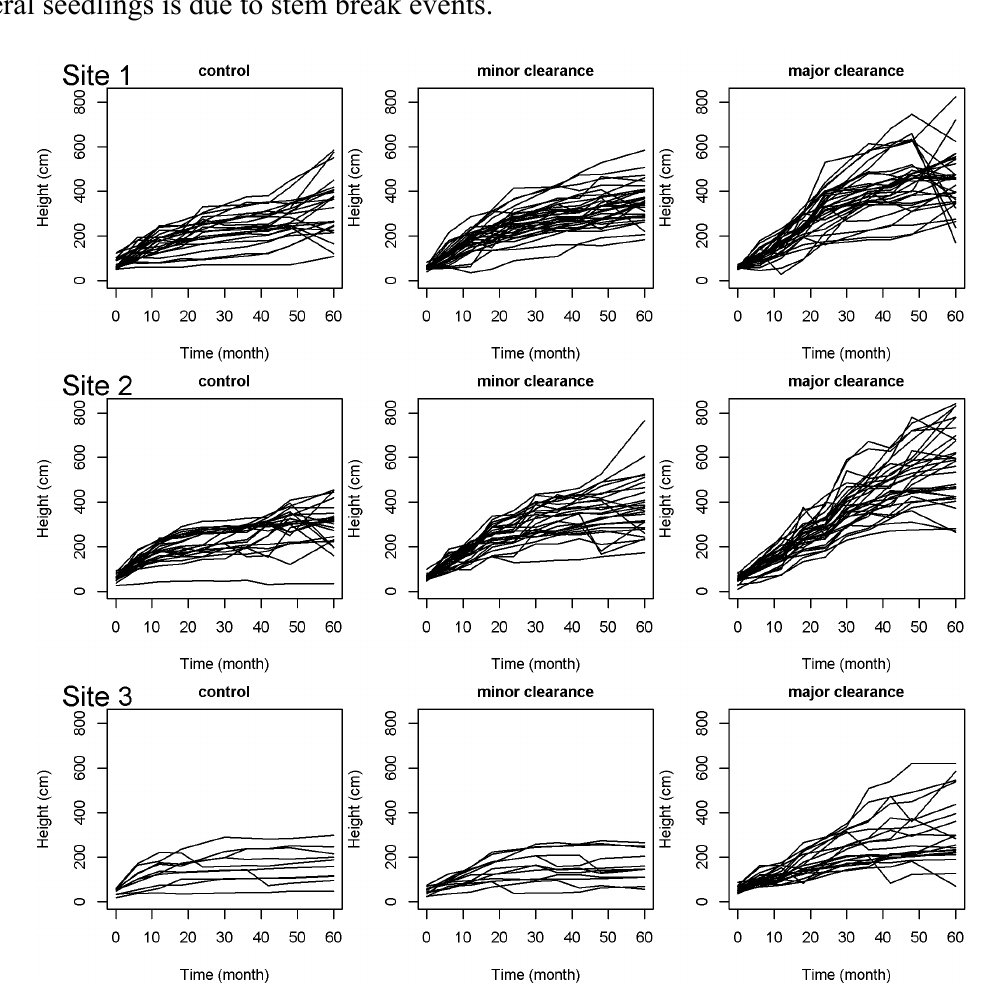
Figure 2. Height growth trajectory for each seedling of P. elata in logging gaps left without any maintenance (control), partially cleared (one-meter around the seedling, minor clearance), and totally cleared (major clearance). The discontinuous height trajectory for several seedlings is due to stem break